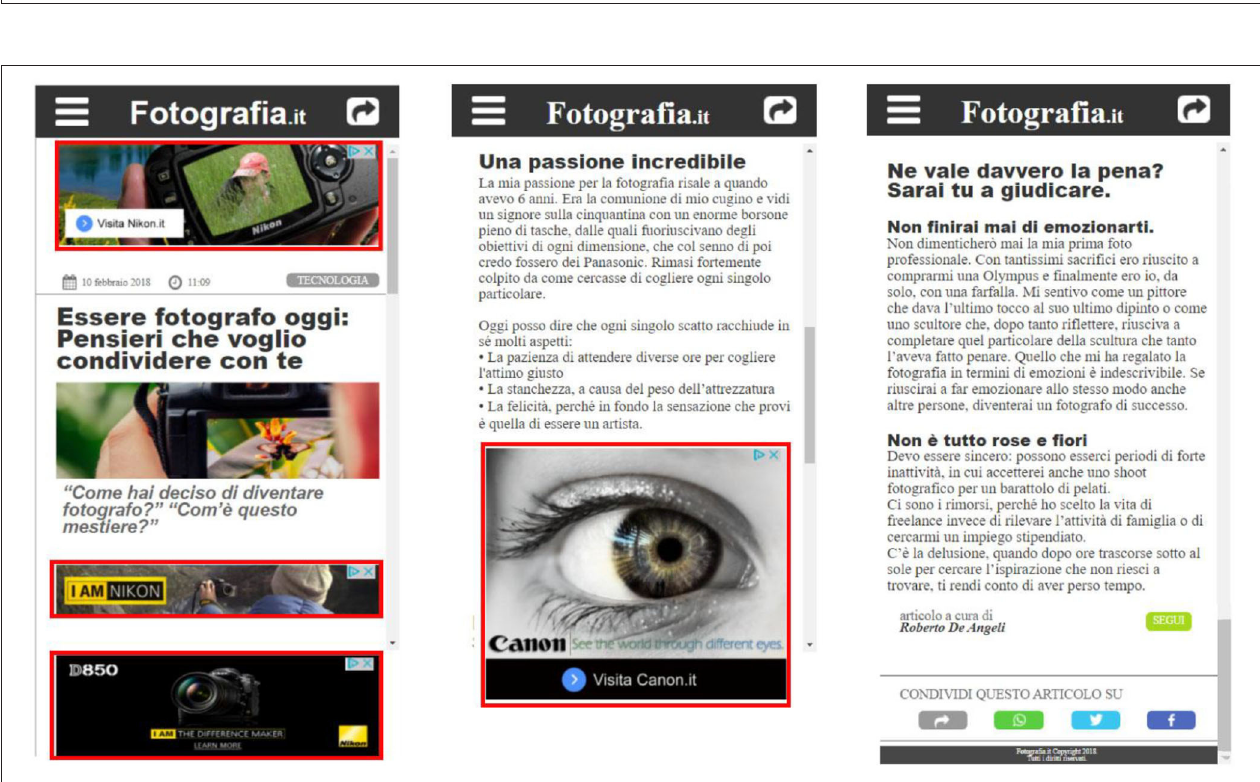
FIGURE 2 | Articles including the ads: on the left side two samples of articles including display ads are shown, while on the right side, the same samples including native ads are shown. Each sample, regardless of the ad format, shows three ads of the total four, since the fourth ad, to be seen by the user, is required to scroll, an action that each participant performed to read the article. The third ad located in each sample was fixed and always visible while scrolling the page.